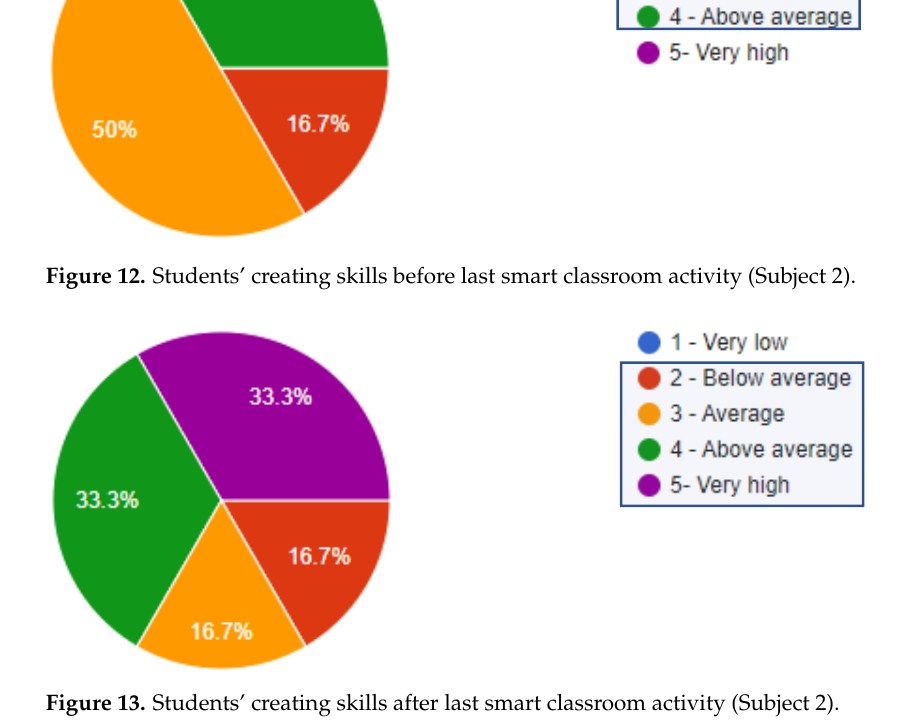
Figure 13. Students’ creating skills after last smart classroom activity (Subject 2).